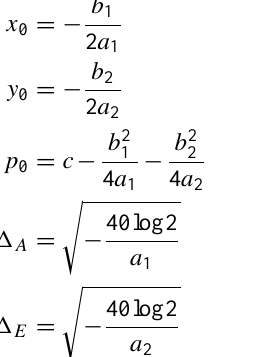
Fig. 4. Radar deployment in Davos (Switzerland). Swisstopo has provided the map of Switzerland in the upper panel.